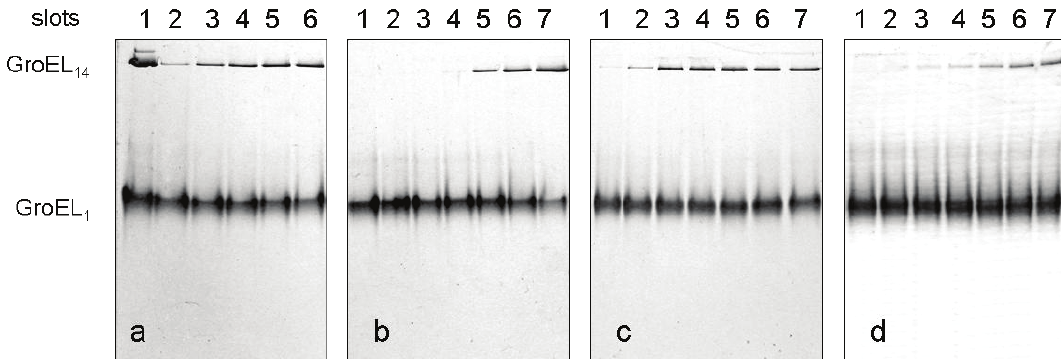
Figure 4. The effect of the factors stimulating GroEL reassembly. Nondenaturing electrophoresis of GroEL monomers after 180 min incubation: ( a ) in 20 mM Tris-HCl, pH 7.5, 5 mM β ME, 100 mM (NH ) SO , 0.4 M urea, 10 mM ATP and at various concentrations of MgCl 4 2 4 (slots: 2 — 0.1 mM, 3 — 0.5 mM, 4 — 1 mM, 5 — 5 mM, and 6 — 10 mM). Slot 1 – the mixture of GroEL and GroEL in 20 mM Tris-HCl, pH 7.5; ( b ) in 20 mM Tris-HCl, pH 7.5, 5 mM 14 1 β ME, 0.4 M urea, 10 mM MgCl , 10 mM ATP and at various concentrations of (NH 2 (slots: 1 – 0 M, 2 – 1 mM, 3 – 5 mM, 4 – 10 mM, 5 – 50 mM, 6 – 100 mM, and 7 – 200 mM); ( c ) in 20 mM Tris-HCl, pH 7.5, 5 mM β ME, 0.4 M urea, 100 mM (NH and at various concentrations of ATP (slots: 1 – 0.001 mM, 2 – 0.01 mM, 3 – 0.1 mM, MgCl 2 4 – 0.5 mM, 5 – 1 mM, 6 – 5 mM, and 7 – 10 mM); ( d ) in 20 mM Tris-HCl, pH 7.5, 5 mM β ME, 0.4 M urea, 10 mM MgCl and at various concentrations of glycerol (slots: 1% – 14%, 2 2% – 16%, 3% – 18%, 4% – 20%, 5% – 26%, 6% – 28%, and 7% – 30%). The concentration of folded monomers in incubation mixtures was 0.4